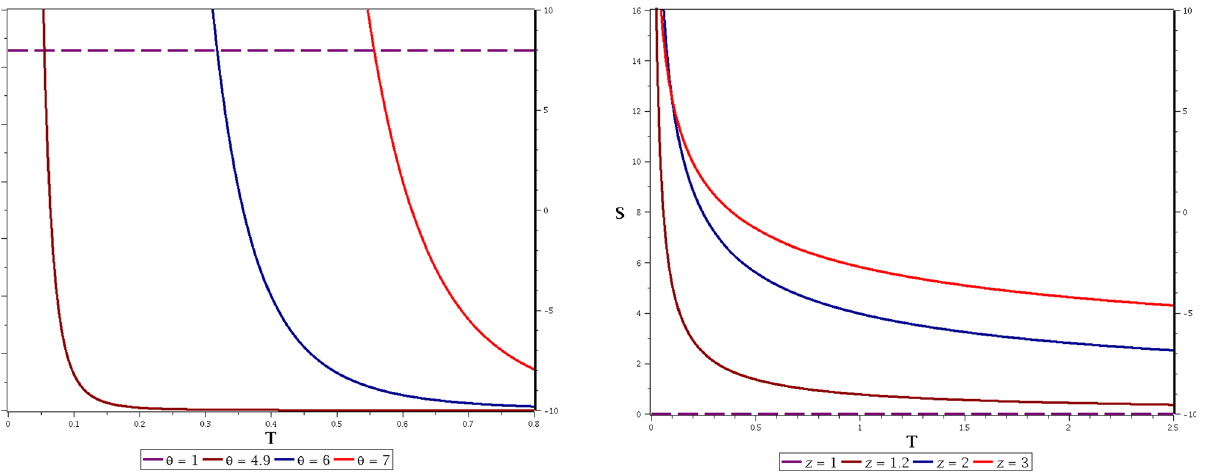
Fig. 9 Entropy as function of the temperature for the fixed reference values D = 5, z = 3, V = 1, κ = 1 and b = 1. We exemplify with families of curves at different θ > 1 and observe that the entropy for fixed temperature is always higher than that of the configurations at θ = 1